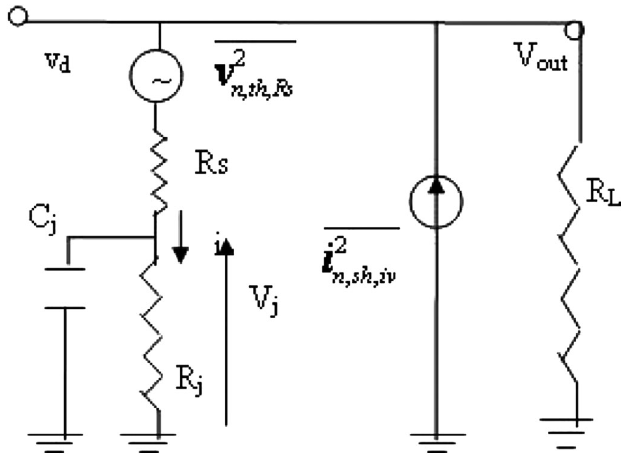
FIG. 3. Diode detector with equivalent noise sources.FIG. 2. Measurement setup.